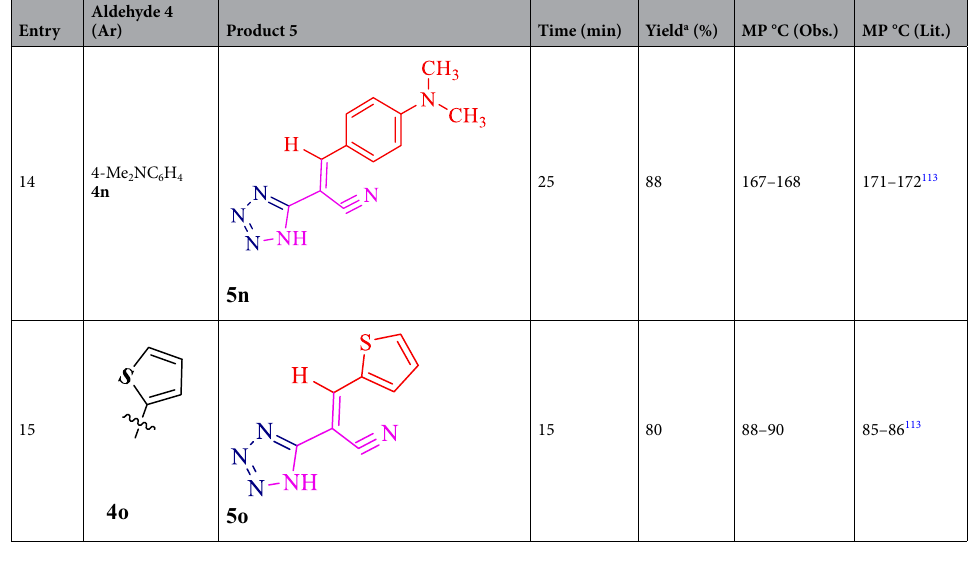
Table 3. Synthesis of 5-substituted-1 H -tetrazole derivatives 5a–o catalyzed by the Fe 3 O 4 @PMO-ICS-ZnO nanocatalyst ( 1 ) via the three components reaction strategy. Reaction conditions: malononitrile ( 2 , 1 mmol), aldehyde ( 4 , 1 mmol), and NaN 3 ( 3 , 1.2 mmol) were added into the EtOH (2.0 mL) in the presence of 10 mg of